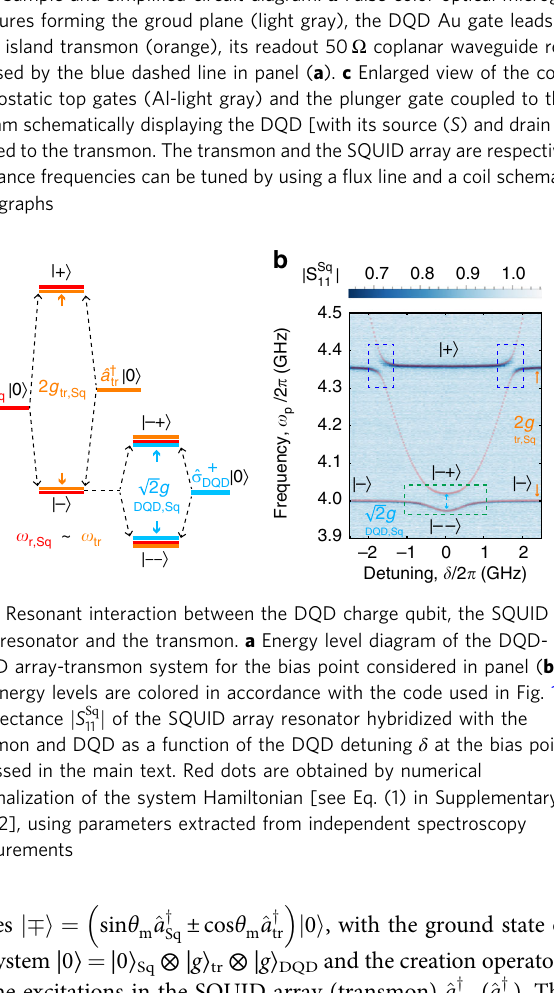
y y ( ^ a ). The tr Sq tr